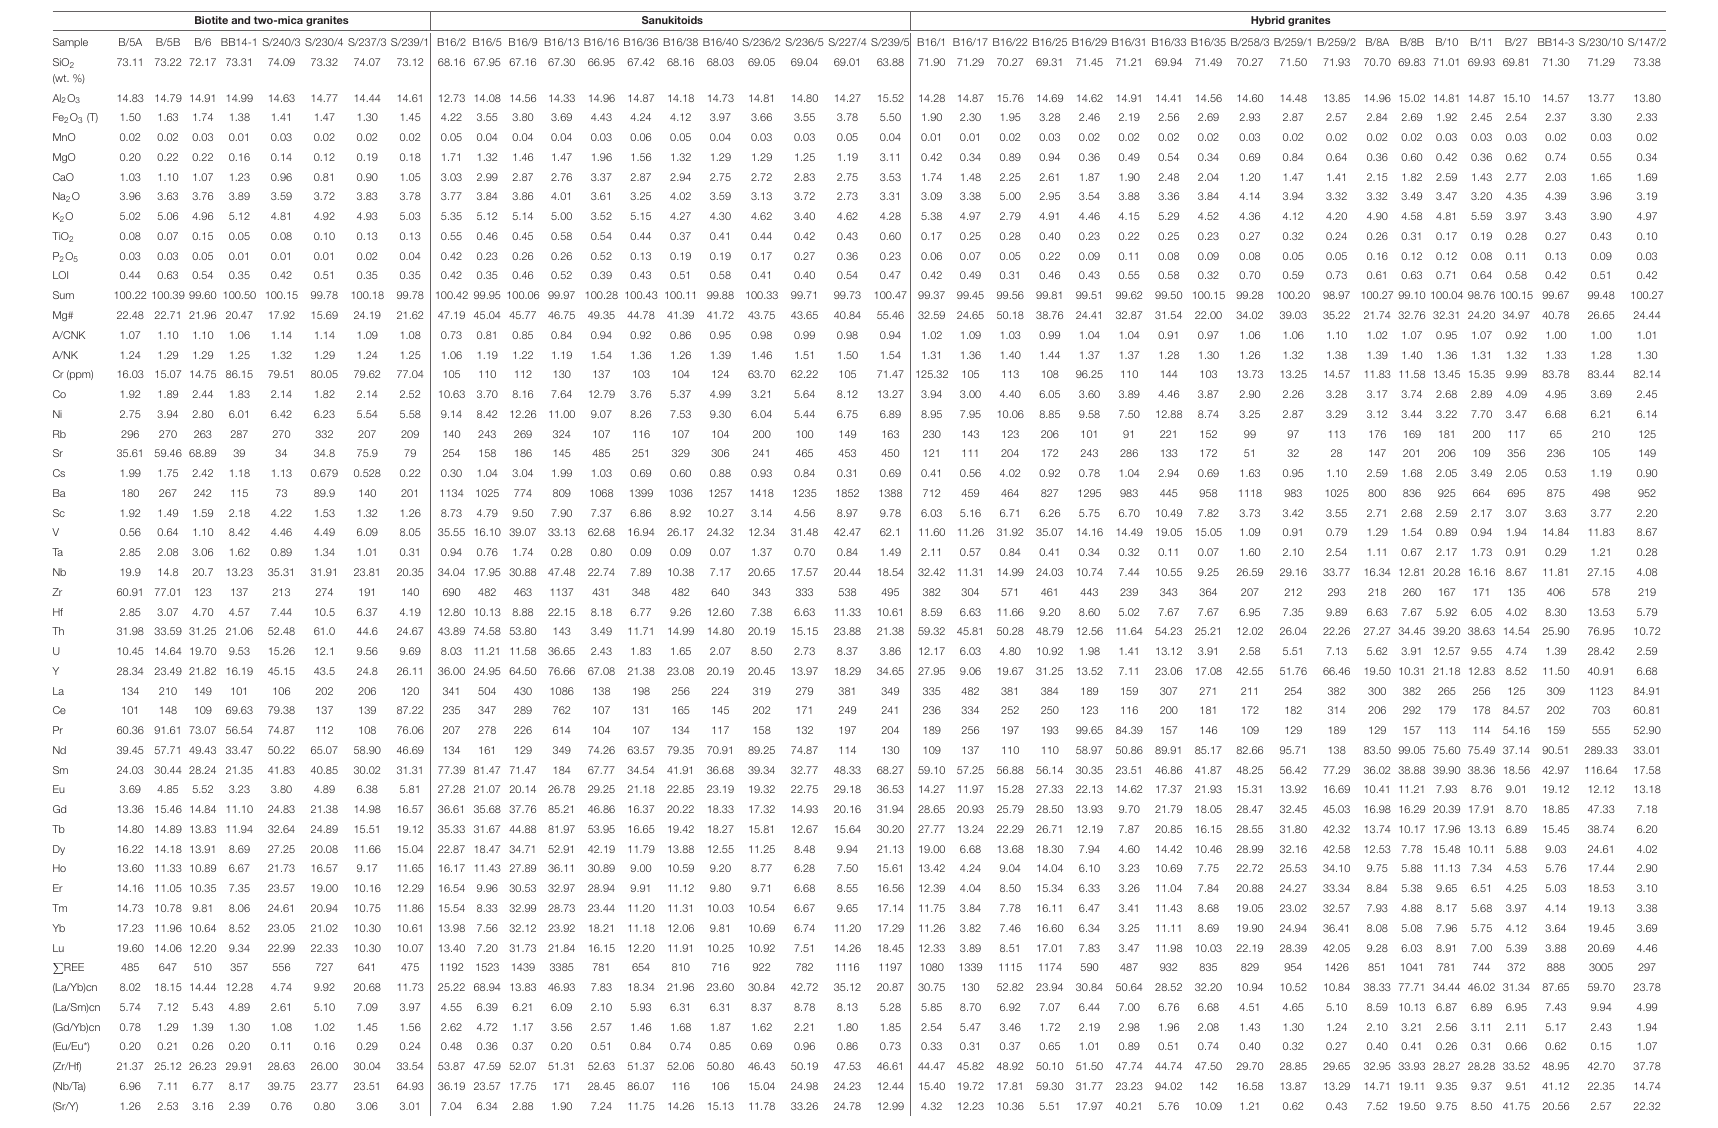
TABLE 1 | Major and trace elemental compositions of the Kanker granites. Biotiteandtwo-micagranites Sanukitoids Hybridgranites